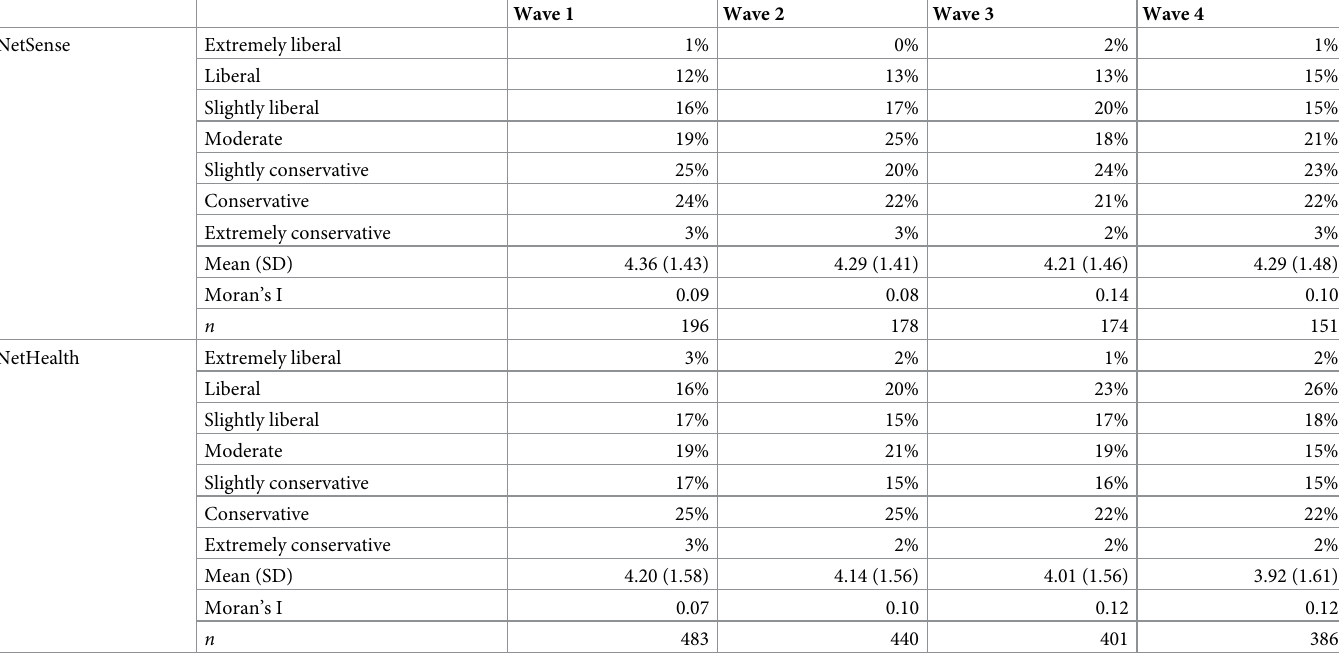
Table 1. Frequency distribution, mean/SD, and network autocorrelation of political orientation among NetSense and NetHealth study